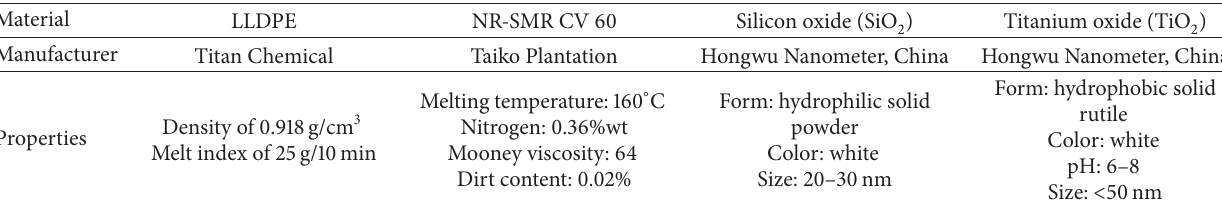
Table 1: Detailed properties of materials.